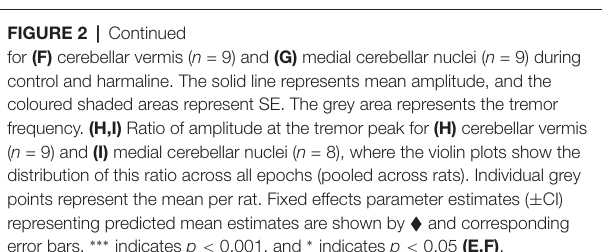
FIGURE 2 | Continued for (F) cerebellar vermis ( n = 9) and (G) medial cerebellar nuclei ( n = 9) during control and harmaline. The solid line represents mean amplitude, and the coloured shaded areas represent SE. The grey area represents the tremor frequency. (H,I) Ratio of amplitude at the tremor peak for (H) cerebellar vermis ( n = 9) and (I) medial cerebellar nuclei ( n = 8), where the violin plots show the distribution of this ratio across all epochs (pooled across rats). Individual grey points represent the mean per rat. Fixed effects parameter estimates ( ± CI) representing predicted mean estimates are shown by (cid:7) and corresponding error bars. ∗∗∗ indicates p < 0.001, and ∗ indicates p < 0.05 (E,F) .